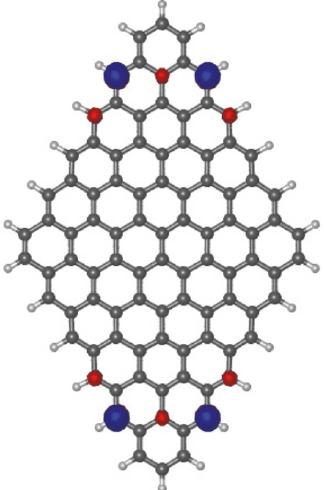
Figure 16: R 6 magnetic orbital